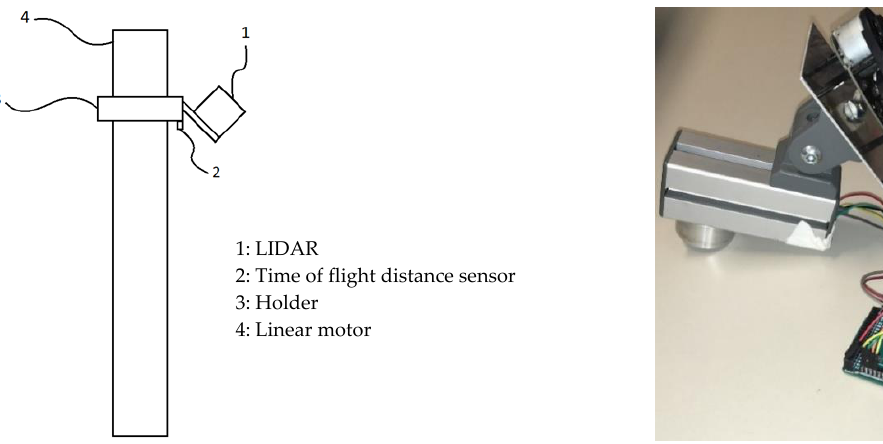
Figure 3. Schematical illustration of the measurement system (left) and real measurement module (right).